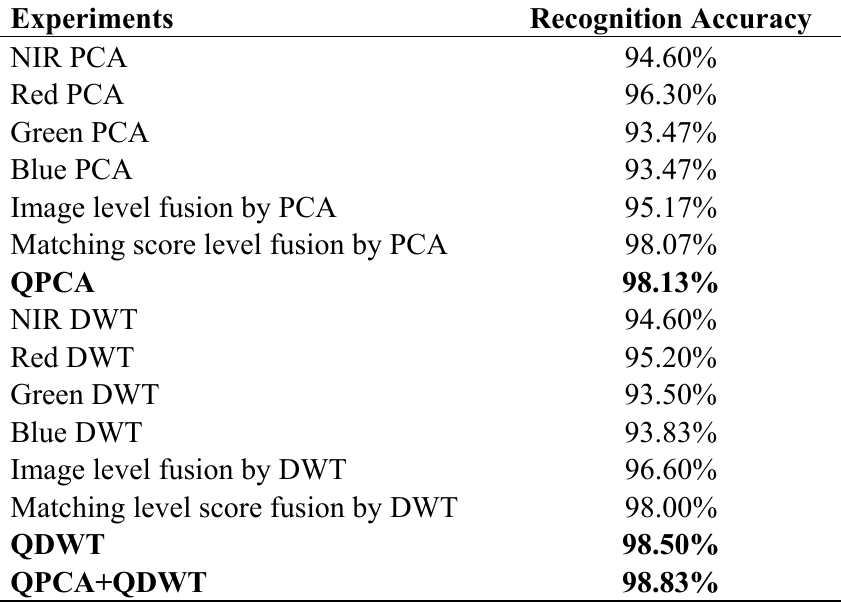
Table 1. Recognition Accuracy.